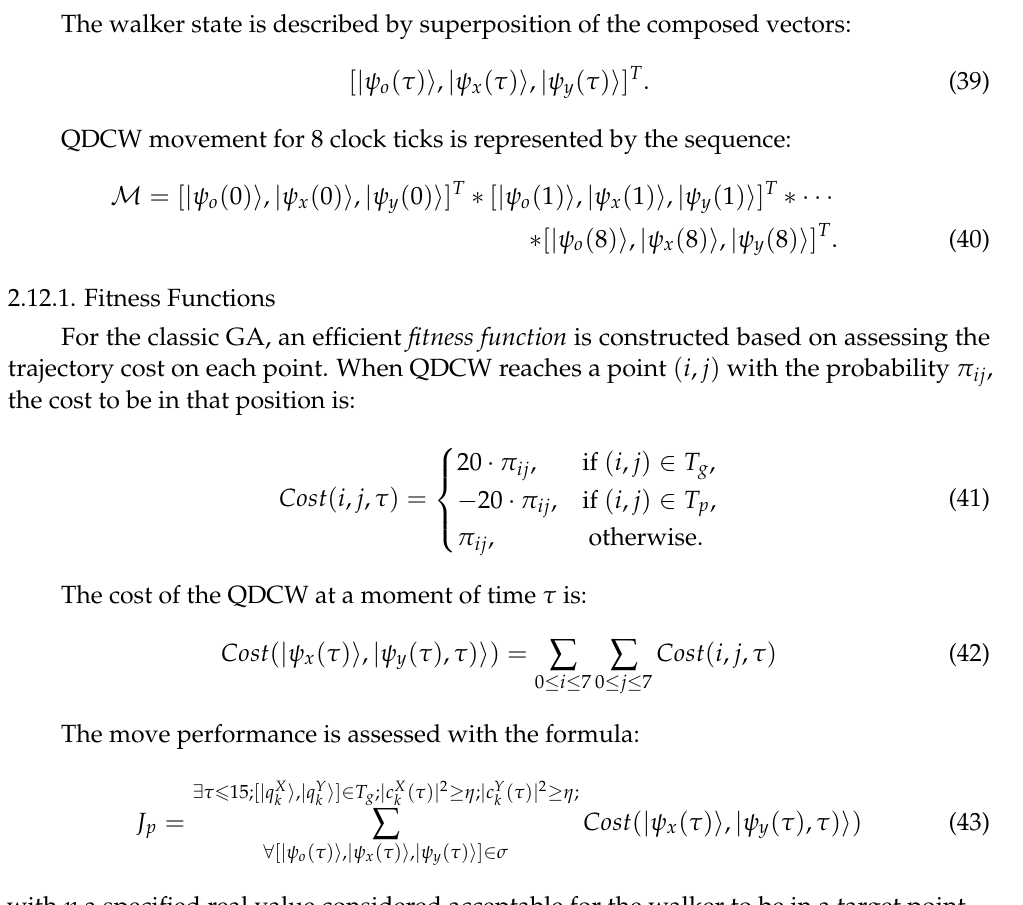
Figure 18. Representation of the targets and traps of the QDCW problem solved by a classic